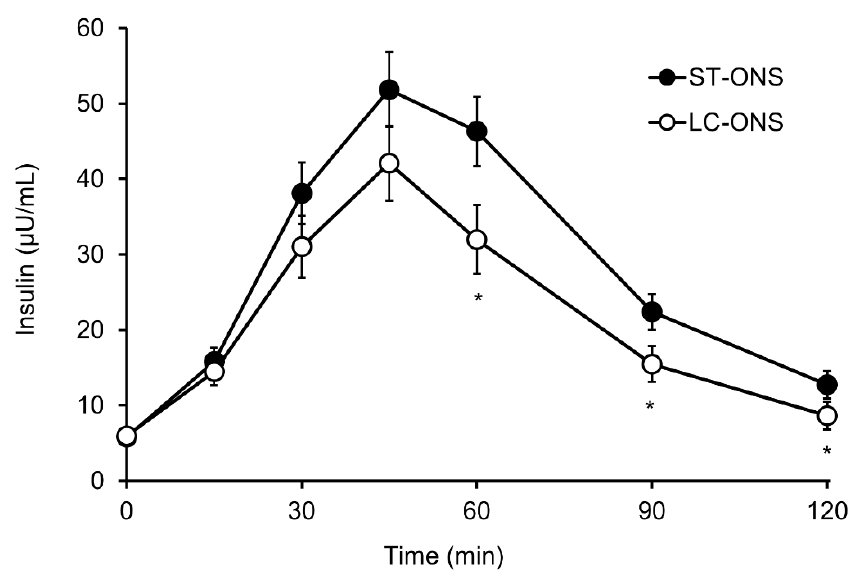
Figure 3. Postprandial levels of insulin after ingestion of a low-carbohydrate-type oral nutritional supplement (LC-ONS) or a standard-type ONS (ST-ONS) ( n = 20). Values are expressed as the least mean square value ± standard error; * p < 0.05 comparing ST-ONS vs LC-ONS.